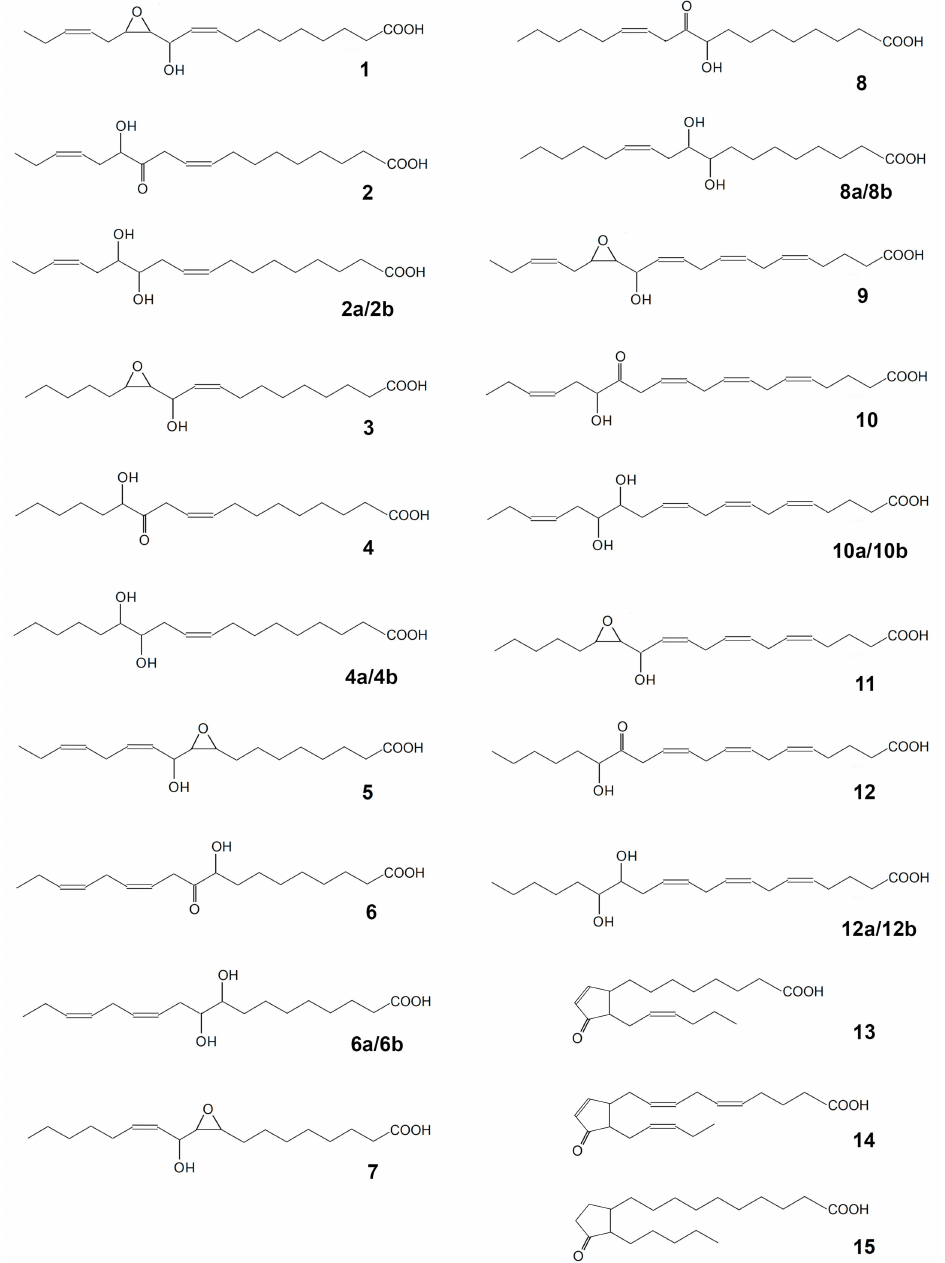
Figure 4. The structural formulae of products of recombinant CYP440A18 enzyme incubations with different substrates: 1 , 11-hydroxy-12,13-epoxy-9,15-octadecadienoic acid; 2 , (9 Z ,15 Z )-12-oxo-13-hydroxy-9,15-octadecadienoic acid ( α -ketol); 2a/2b , threo/erythro 12,13-diols (12,13-dihydroxy-9,15-octadecadienoic acid); 3 , 11-hydroxy-12,13-epoxy-9-octadecenoic acid; 4, (9 Z )-12-oxo-13-hydroxy-9-octadecenoic acid ( α -ketol); 4a/4b , threo/erythro 12,13-diols (12,13-dihydroxy-9-octadecenoic acid); 5 , 9,10-epoxy-11-hydroxy-12,15-octadecadienoic acid; 6 , (12 Z ,15 Z )-9-hydroxy-10-oxo-12,15-octadecadienoic acid ( α -ketol); 6a/6b , threo/erythro 9,10-diols (9,10-dihydroxy-12,15-octadecadienoic acid); 7 , 9,10-epoxy-11-hydroxy-12-octadecenoic acid; 8 , (12 Z )-9-hydroxy-10-oxo-12-octadecenoic acid ( α -ketol); 8a/8b , threo/erythro 9,10-diols (9,10-dihydroxy-12-octadecenoic acid); 9 , 13-hydroxy-14,15-epoxy-5,8,11,17-eicosatetraenoic acid; 10 , 14-oxo-15-hydroxy-5,8,11,17-eicosatetraenoic acid ( α -ketol); 10a/10b , threo/erythro 14,15-diols (14,15-dihydroxy-5,8,11,17-eicosatetraenoic acid); 11 , 13-hydroxy-14,15-epoxy- 5,8,11-eicosatrienoic acid; 12 , 14-oxo-15-hydroxy-5,8,11-eicosatrienoic acid ( α -ketol); 12a/12b , threo/erythro 14,15-diols (14,15- dihydroxy-5,8,11-eicosatrienoic acid); 13 , cis -12-oxo-10,15-phytodienoic acid; 14 , dihomo- cis -12-oxo-3,6,10,15-phytodienoic acid; 15 , dihomo-12-oxophytonoic